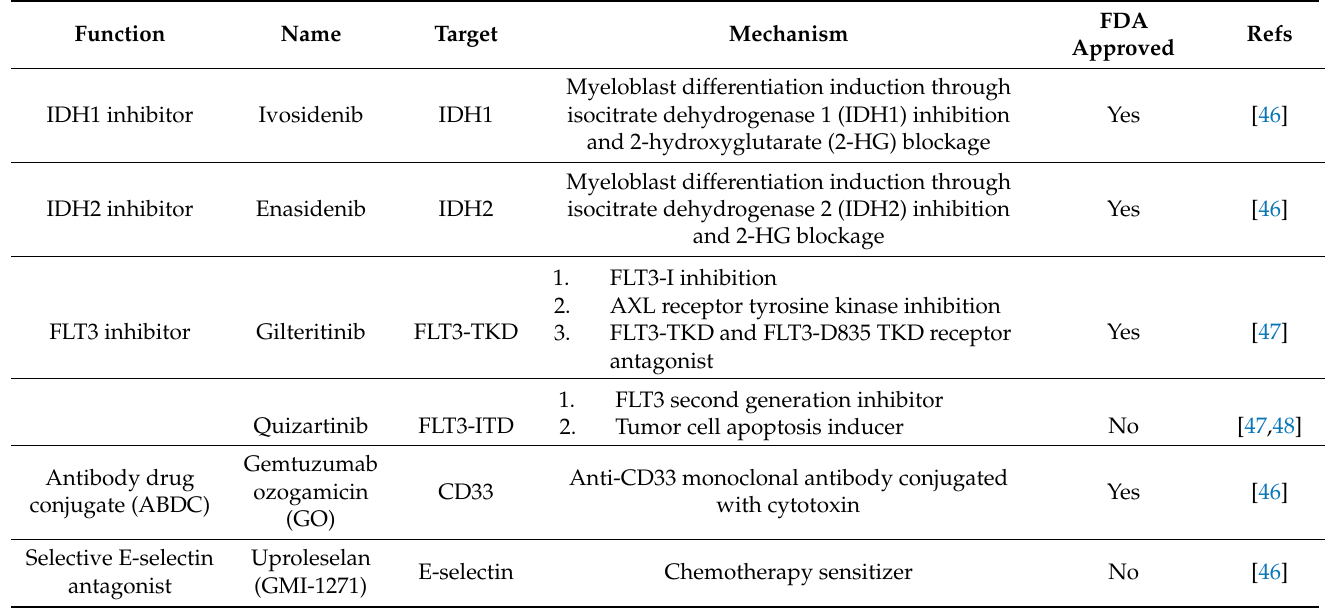
Table 2. Medications with the purpose of AML targeted